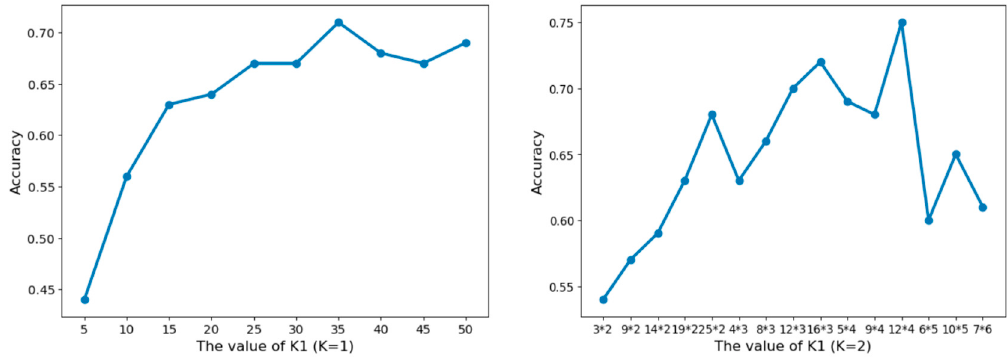
Figure 5. Classification accuracy with different values of 𝑘1 .